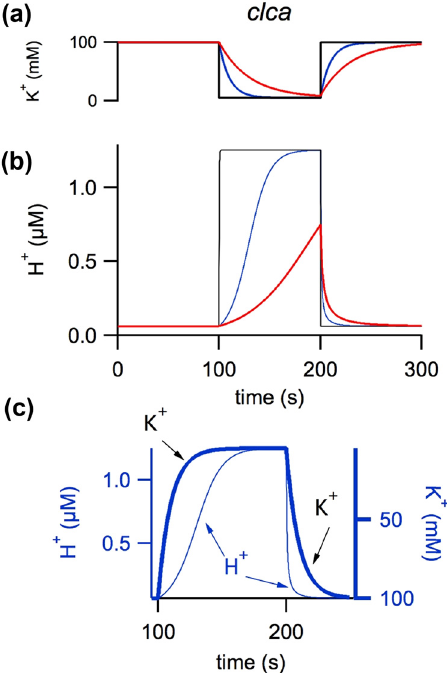
Figure 2: Simulation of the vacuolar acidi fi cation mediated by NHXs induced by a cytosol - directed potassium gradient. ( a ) Change in cytosolic potassium. ( b ) Corresponding response in luminal proton concentration variation. Traces in A were calculated considering instantaneous perfusion ( black line ) or a perfusion system with a time constant of 10 ( blue line ) or 30 s ( red line ) . Traces in B were calculated using equation ( 1 ) . ( c ) Superimposition of cytosolic potassium concentration ( thick blue line ) and luminal proton con - centration to favor a direct comparison. Modi fi cation of Figure S9 from Gradogna et al. [ 57 ] , New Phytologist , 229:3026 – 36, reprinted